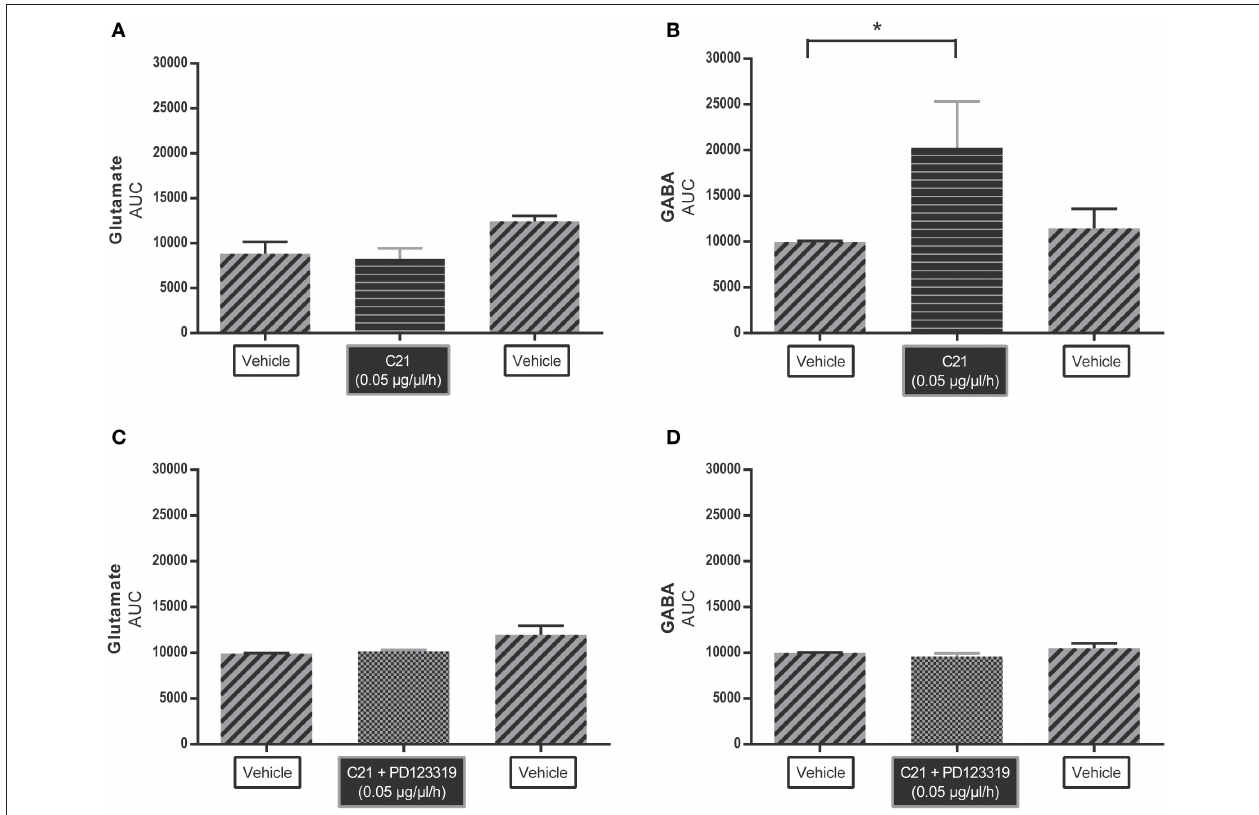
FIGURE 2 | Microdialysis experiment: area under the curve (AUC) values of C21 alone (A) ( n = 4) and (B) ( n = 6) and in co-infusion with PD123319 (C) ( n = 4) and (D) ( n = 5) applied by microdialysis into the RVLM in normotensive freely moving Wistar rats on extracellular levels of glutamate (A,C) and GABA (B,D) . Data are represented as the mean AUC ± SEM. Statistical analysis for overall differences in neurotransmitter (glutamate and GABA) concentrations between different compounds is performed using Kruskal Wallis test with Dunn’s multiple comparison test; significant data are indicated by asterisks (* p < 0.05).